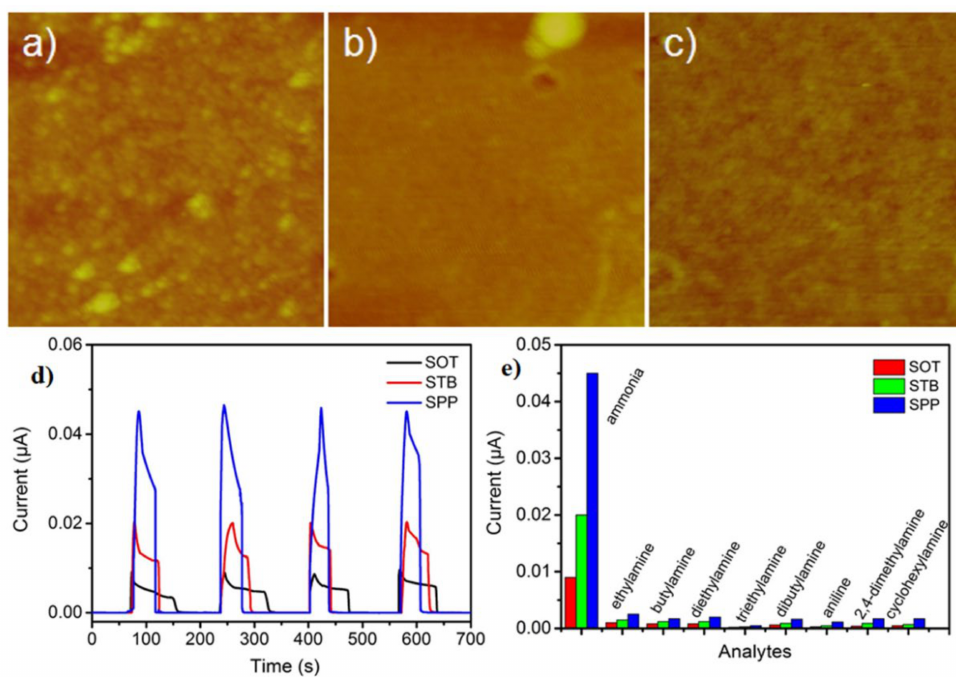
Figure 12. AFM images of ( a ) SOT, ( b ) STB, and ( c ) SPP thin films (2 × 2 µ m) illustrating a similar morphology. ( d ) Dynamic current change of SOT, STB, and SPP devices in ammonia (100 ppm). ( e ) Current change for SOT, STB, and SPP devices exposed to numerous amine analytes. Adapted with permission